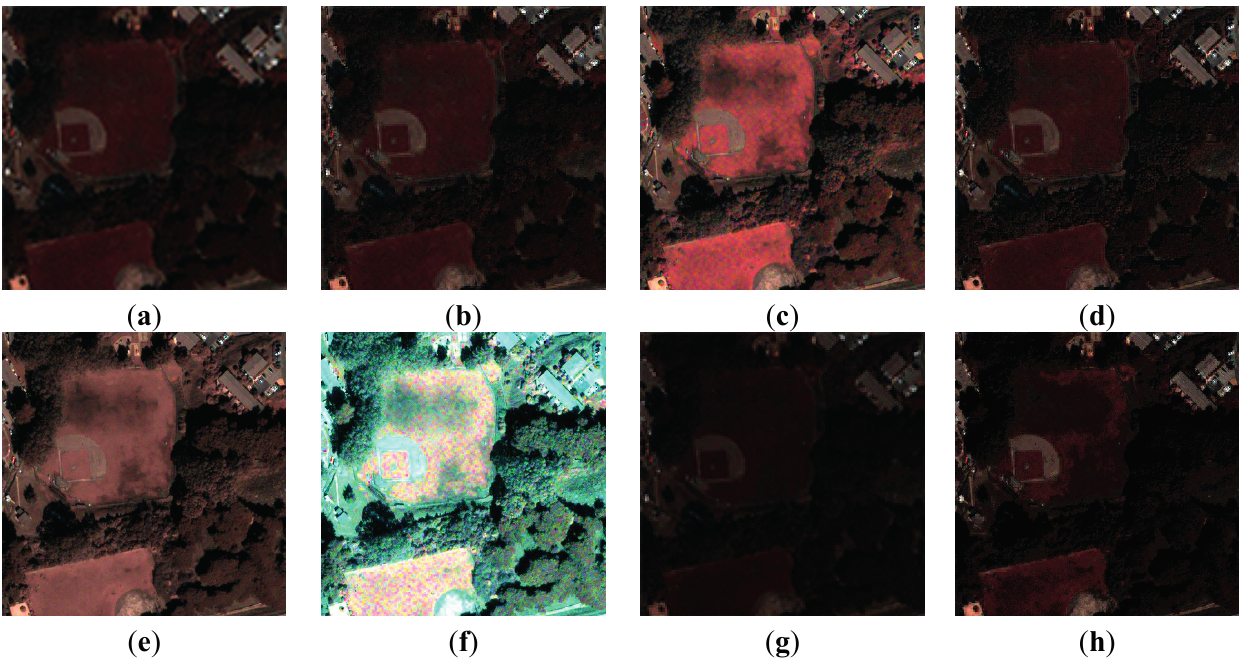
Figure 11. ( a ) Multispectral Image of vegetation image. ( b ) BEMD fusion image. ( c ) IHS fusion image. ( d ) Wavelet fusion image. ( e ) PCA fusion image. ( f ) Brovey fusion image. ( g ) Gaussian high-pass spatial filter fused image. ( h ) Laplacian pyramidal decomposition image.